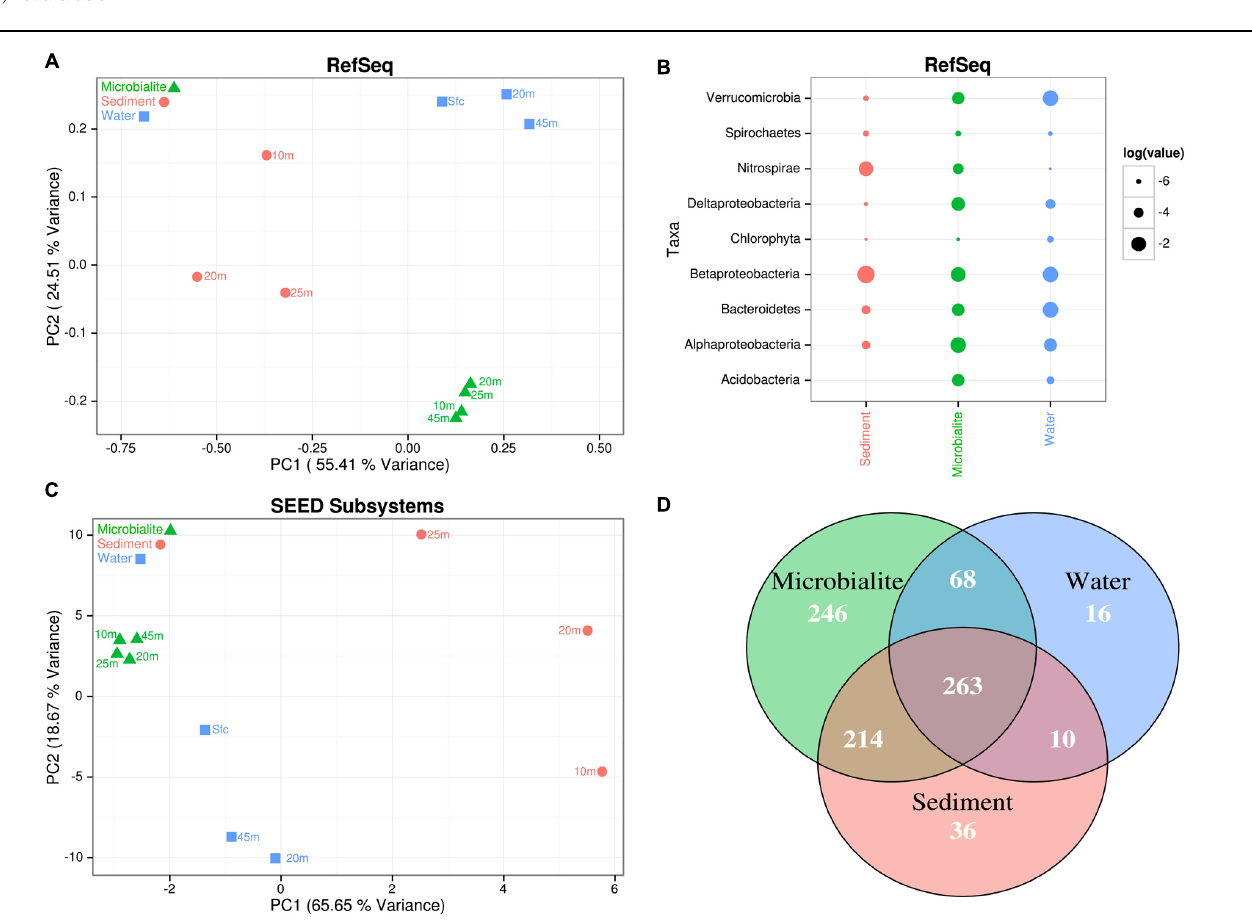
FIGURE 2 | Pavilion Lake microbial community composition and metabolic potential relative to the adjacent sediments and water. (A) PCA plot of the normalized RefSeq classifications. Clustering was done using a ward matrix and Bray-Curtis distance cut-offs, bootstrapped with one thousand replicates. (B) Dotplot of the normalized RefSeq class-level in log relative abundances. (C) PCA plot of the normalized SEED Subsystems (level II classifications). Clustering was done using a ward matrix and Bray-Curtis distance cut-offs, bootstrapped with one thousand replicates. (D) Venn diagram of the MetaCyc pathway abundances for all the microbialite, water and sediment metagenomes normalized by pathway gene abundances and pathway